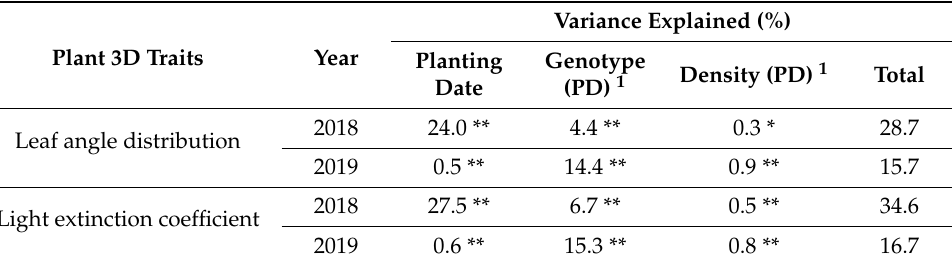
Table 5. Analysis of variance for canopy leaf angle distribution and light extinction coefficient as affected by planting date, genotype, and